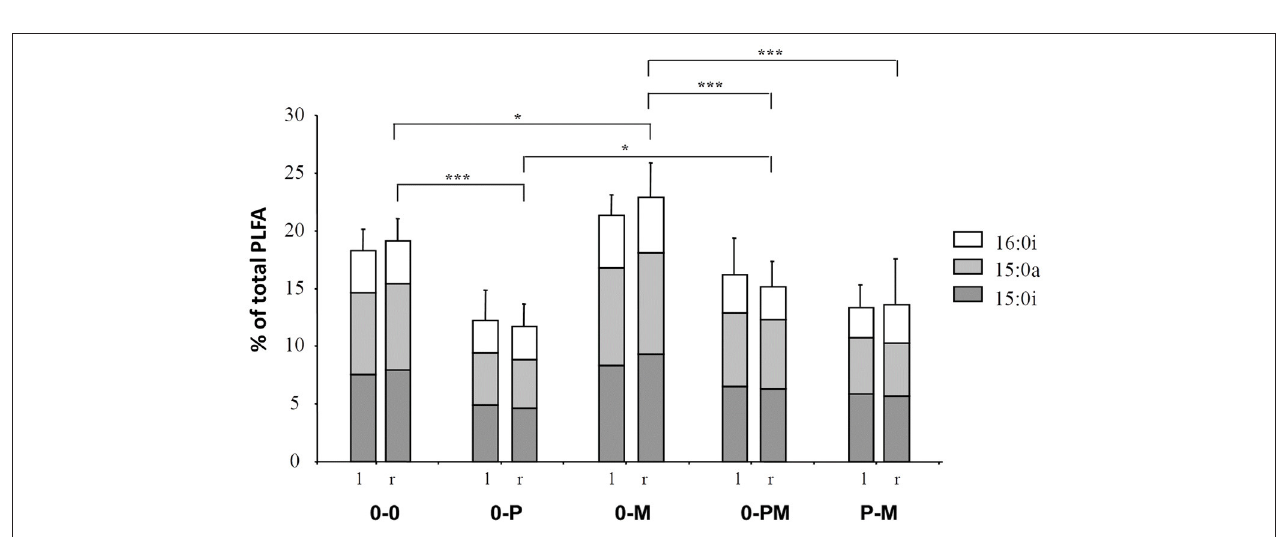
FIGURE 5 | Influence of treatments on the levels of fatty acids (% of total) typical of Gram positive bacteria (15:0i, 15:0a, and 16:0i) in the left (l) and right (r) root compartment, respectively. Treatments: control plants (0-0), plants treated with protists in the right root chamber (0-P), or treated with mycorrhiza in the right root chamber (0-M), or treated with protists and mycorrhiza together in the right root chamber (0-PM), or where the left and right root chambers were separately treated with protists and mycorrhiza (P-M). Mean and standard deviation; * p < 0.05, *** p < 0.001.